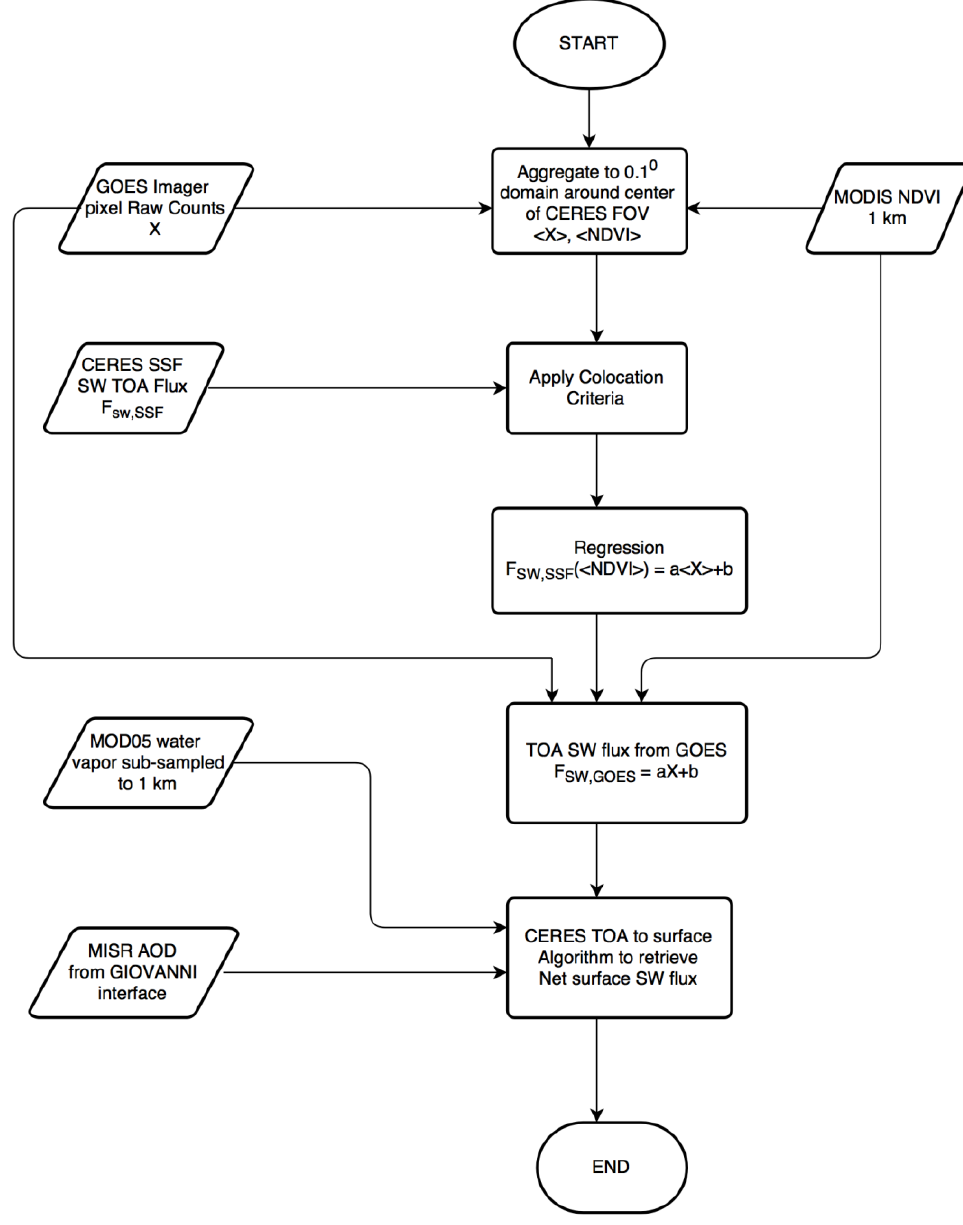
Figure 1. Flowchart depicting the methodology of retrieving net surface flux from GOES imagery. Parameters shown within <> represent average values over